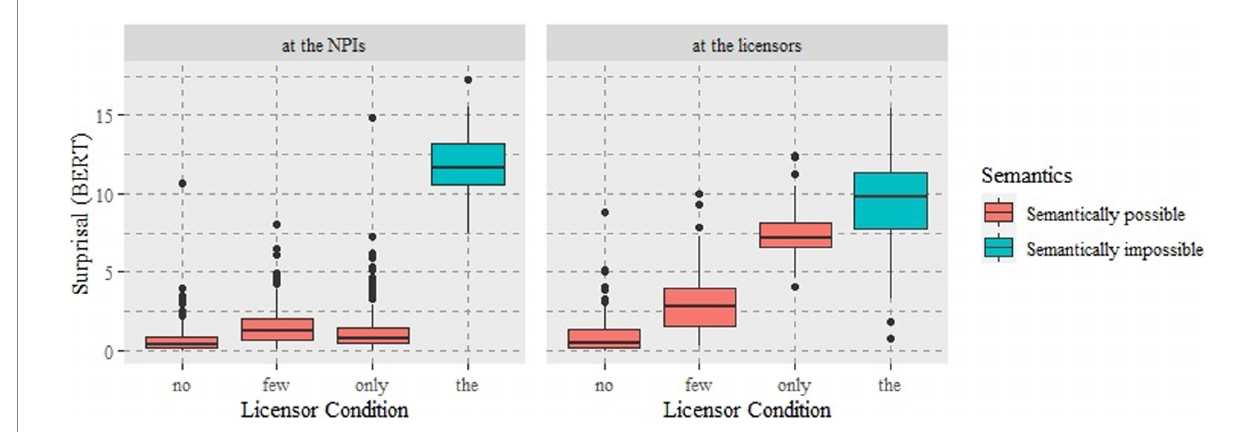
FIGURE 2 The distribution of surprisal at the NPI and at the licensor positions in Experiment